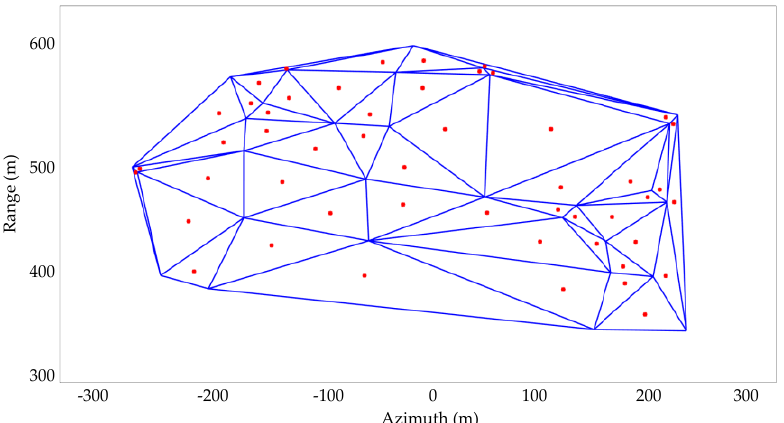
Figure 3. Diagrammatic sketch of Delaunay triangulation. The red points are the pending interpolation points.